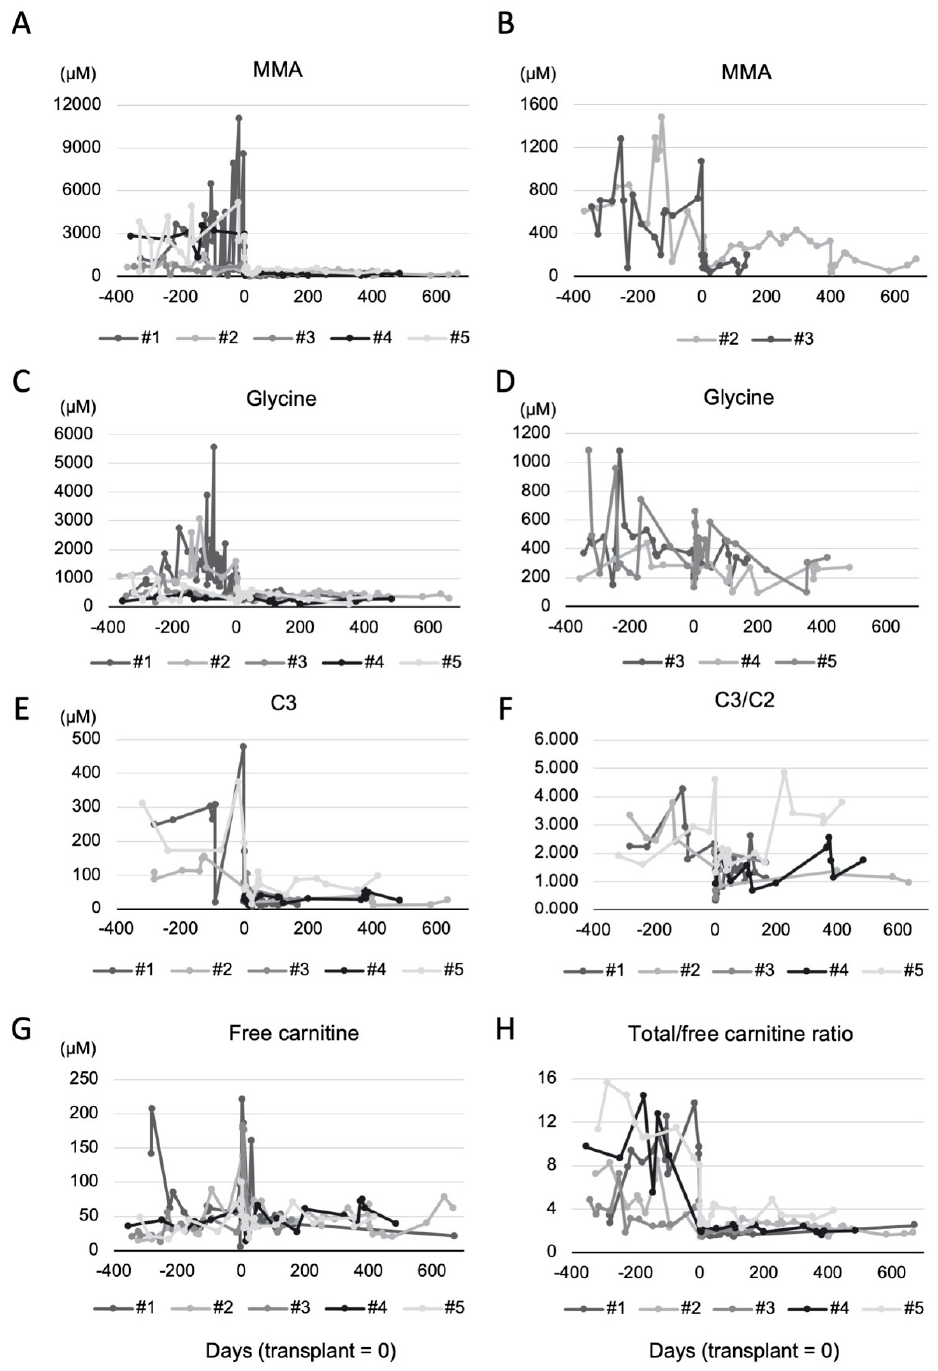
Figure 1. Biochemical profiles of patients six months before and after liver transplant. ( A , B ); plasma MMA level, ( C , D ); plasma glycine level, ( E ); plasma C3 level, ( F ); plasma C3/C2 ratio, ( G ); plasma free carnitine level, ( H ); plasma total/free carnitine ratio. ( B , D ) graphs represent values of patients who had lower MMA or glycine levels compared to the other patients, respectively. 0 of x -axis represents the day of transplant. Numbers of x -axis represent patients’ ID. MMA; methylmalonic acid, C3; propionyl-carnitine, C2; acetyl-carnitine.